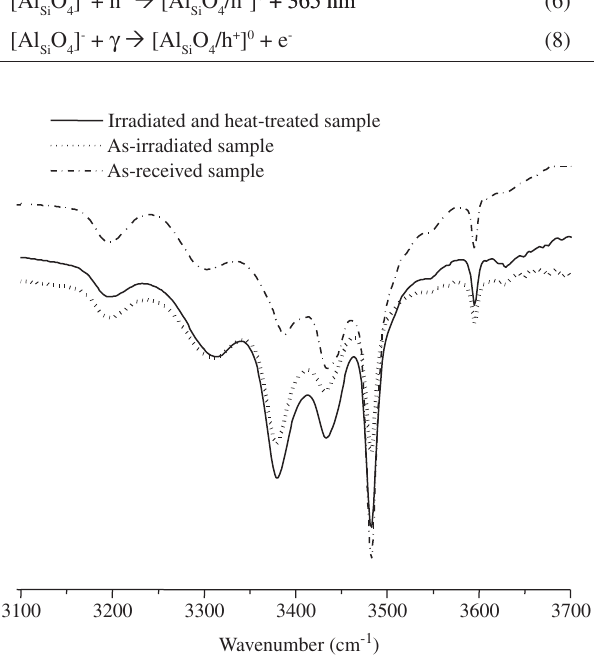
Figure 1. Infrared spectrum (transmittance) of as-received, as-irradiated (200 kGy), and irradiated and heat treated